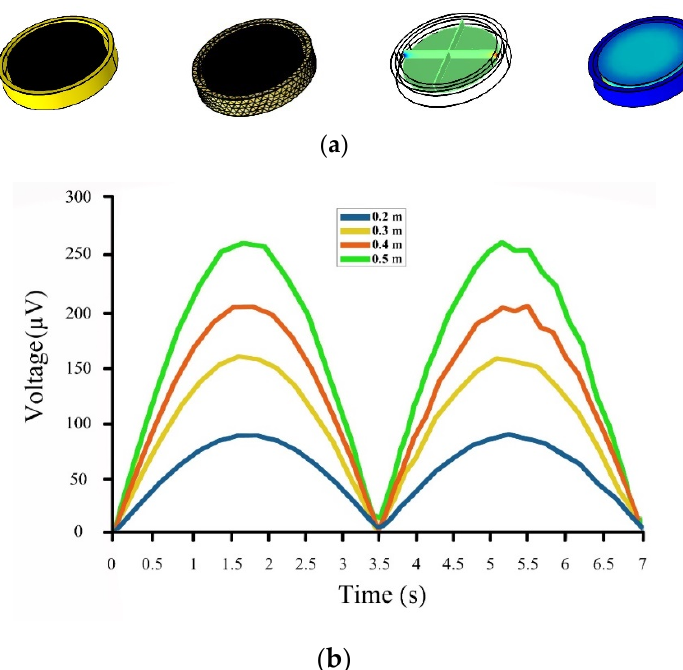
Figure 8. COMSOL models and results: ( a ) Model, meshed model, electrical potential output, and stress output; ( b ) Output voltages for ocean waves of 0.2 m (Blue line), 0.3 m (Yellow line), 0.4 m (Red line), 0.5 m (Green line) height.